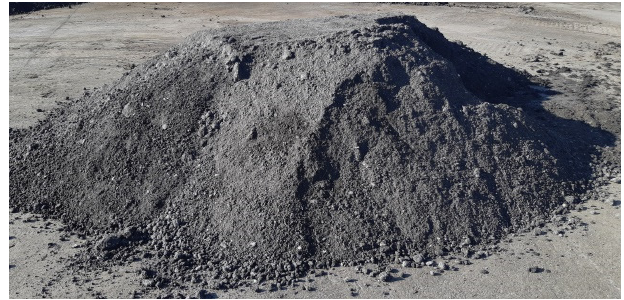
Figure 2. Stabilized municipal sewage sludge used in the investigation. Table 9. Basic properties of municipal sewage sludge and soil used in this study and permissible heavy metal contents according to the Croatian legislation for the use of municipal sewage sludge in agriculture.